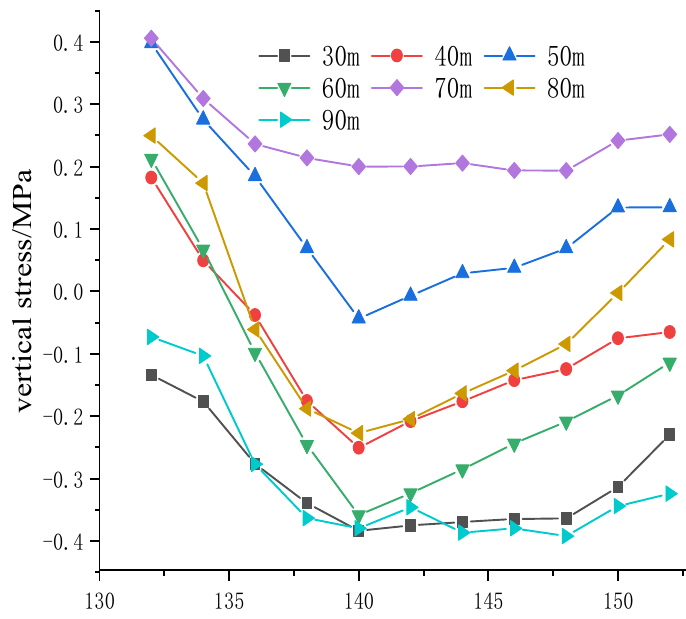
Figure 15. Influence of adjacent roadway excavation disturbance.